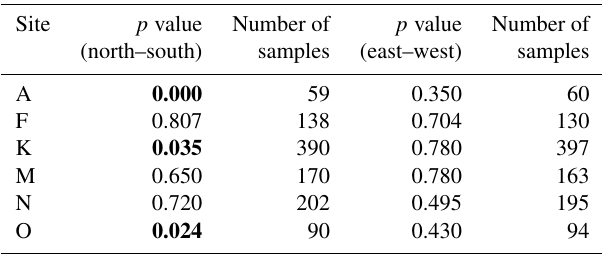
Table A4. Wilcoxon signed-rank test results for comparing snow depth on the north and south sides (and east and west) for individual trees at each site. Note only trees that have snow depth data on both north and south or east and west are considered. Statistically significant values are